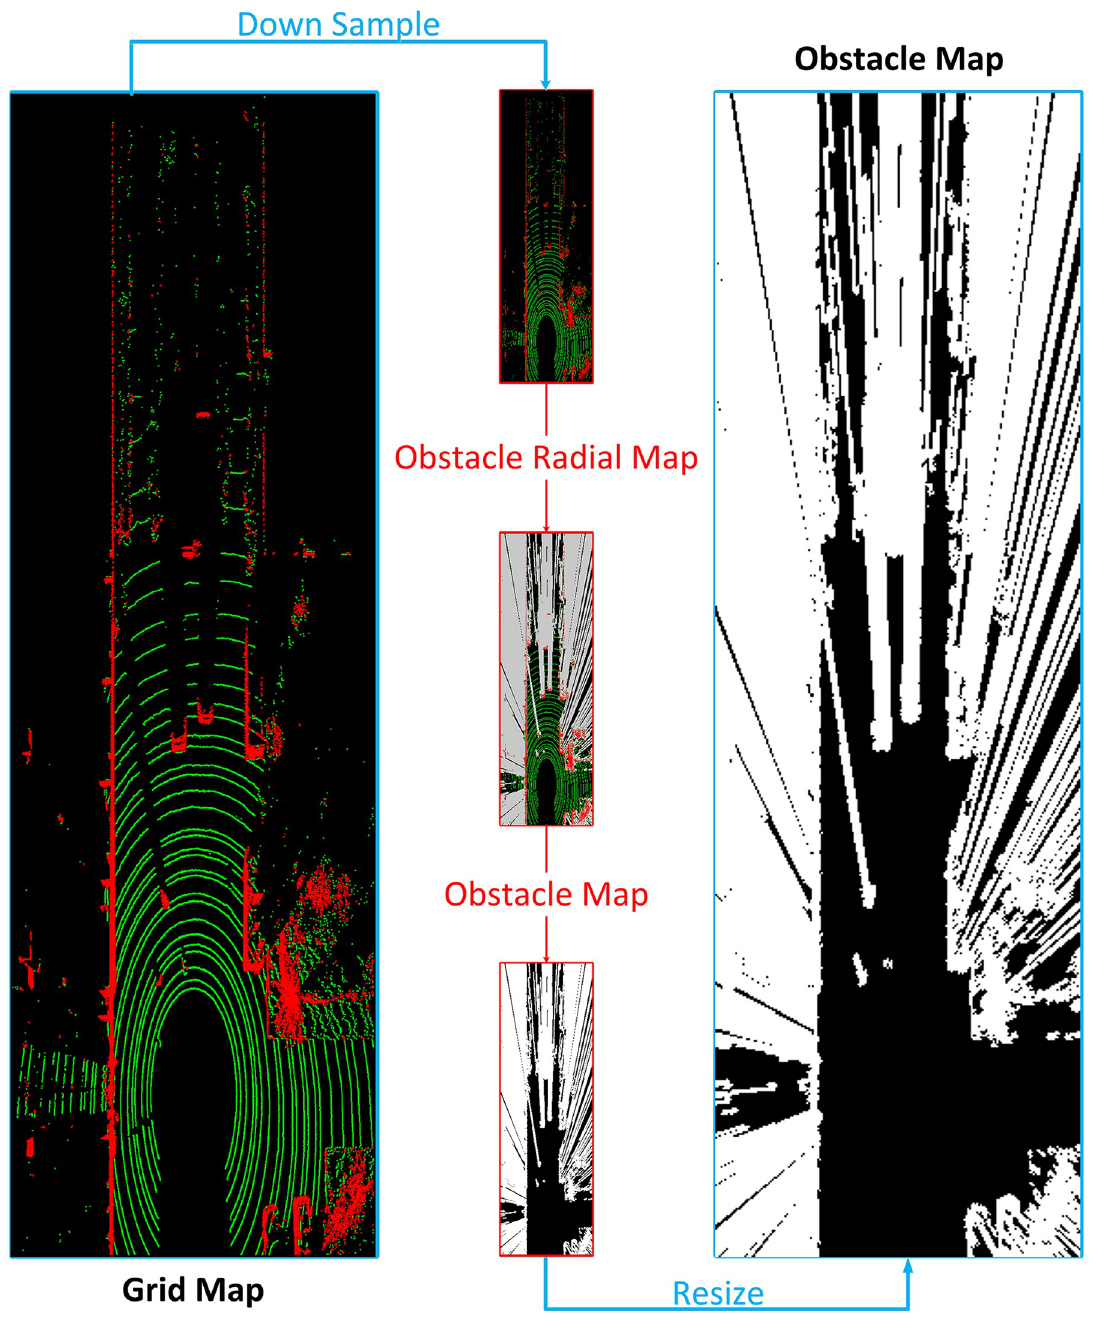
Fig 5. Obstacle map generating